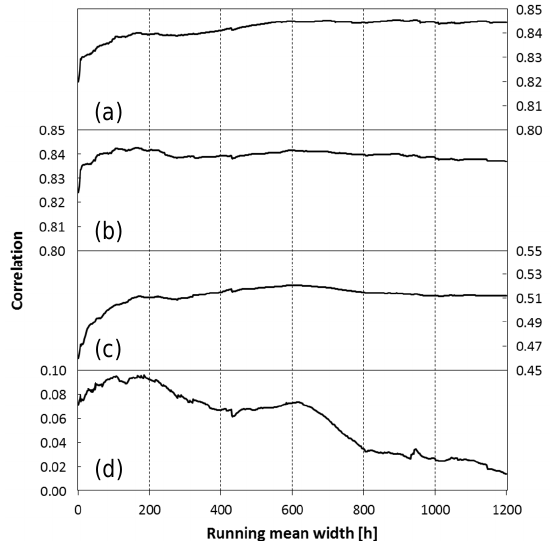
Figure 12. Change of the correlation between the filtered FTIR and NDIR data sets with increasing width of the running mean. (a) Correlation between the two data sets with seasonality and slope; (b) correlation between the two data sets without seasonality; (c) correlation between the two data sets without slope; (d) correla- tion between the two data sets with neither slope nor